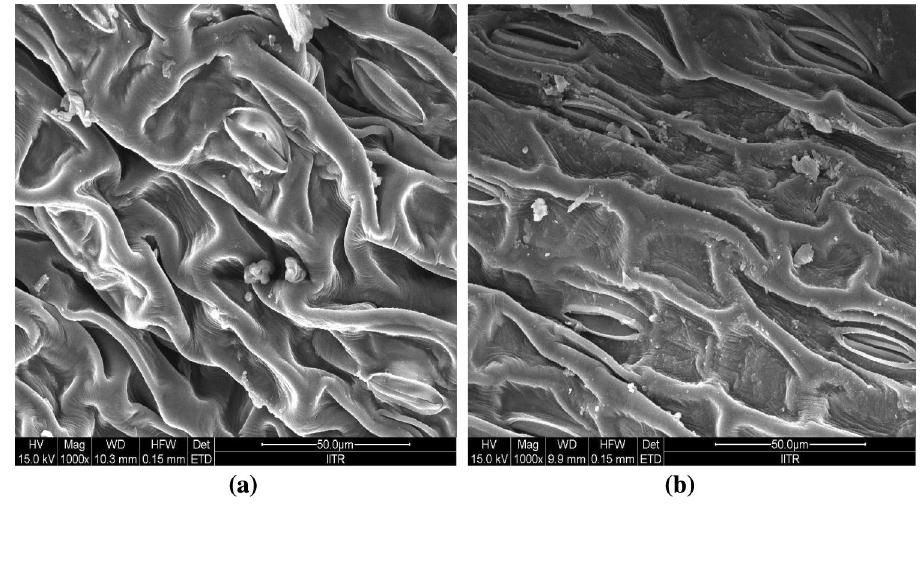
Fig. 3 a EM analysis of Eich- hornia crassipes stem unloaded with phenol and cyanide and b loaded with phenol and cyanide (at a magnification of 1